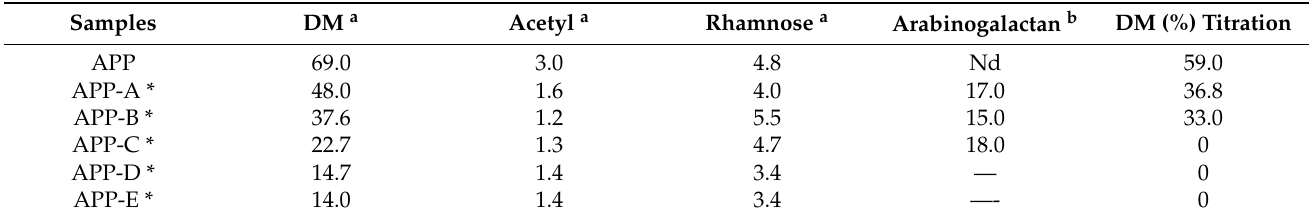
Table 2. Structural characterization of the different pectin samples by 1